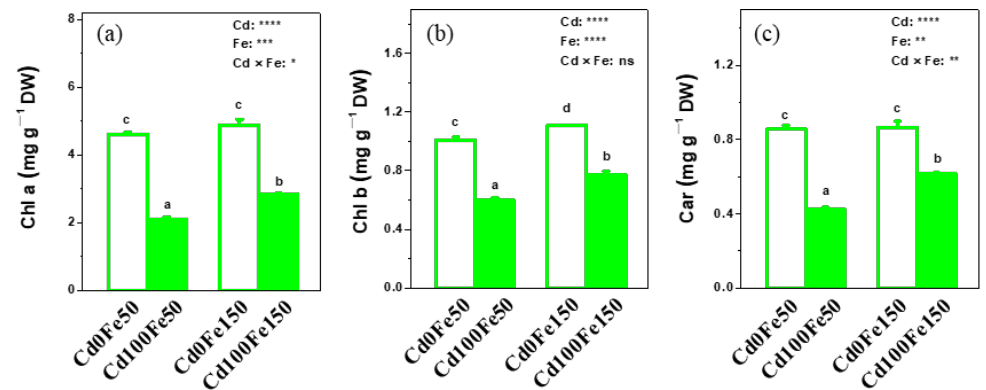
Figure 5. Chl a ( a ), Chl b ( b ), and Car ( c ) in the leaves of poplar under different Cd and Fe combined treatments. Data were means ± SE (n = 6). Different lowercase letters on the bars indicate significant differences in ANOVA ( p < 0.05). p values of two-way ANOVA on Cd, Fe, and their interaction (Cd × Fe) were indicated (*, p < 0.05; **, p < 0.01; ***, p < 0.001; ****, p < 0.0001; ns, not significant).